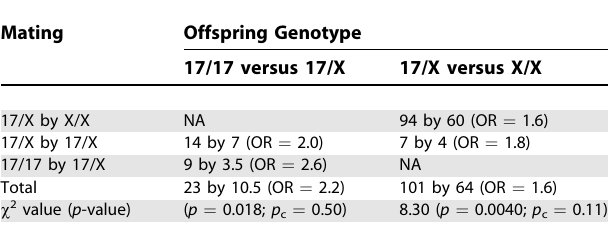
Table 4. The Mode of Inheritance of HLA-DRB1*11 in the Table 2. The Inheritance of HLA-DRB1*17 in the Absence of